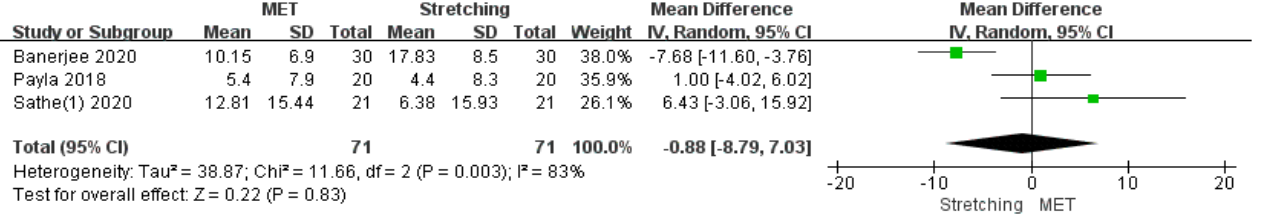
Figure 2. Meta-analysis of active knee extension (AKE) outcomes compared of AKE between muscle energy technique (MET) and stretching groups [33,34,42]. SD: standard deviation; CI: confidence interval. In a meta-analysis of four studies [10,33,43,47] using SRT as an evaluation index